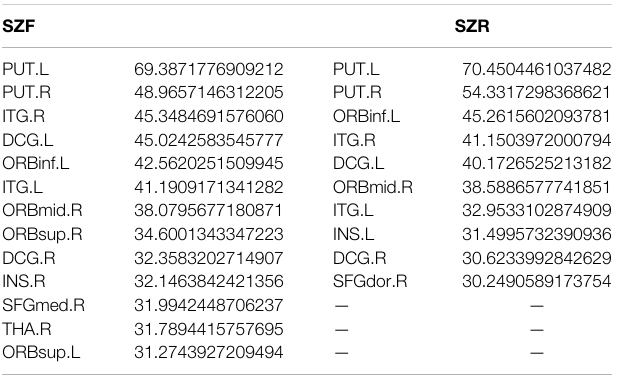
TABLE 6 | Betweenness hubs in the SZR and SZF groups. SZF SZR PUT.L